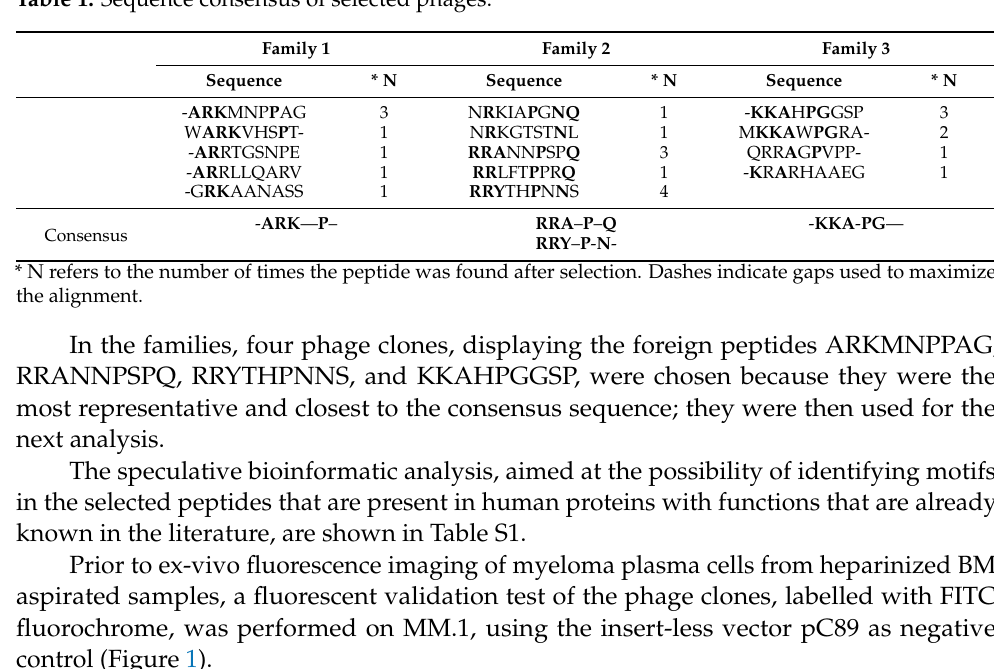
Table 1. Sequence consensus of selected